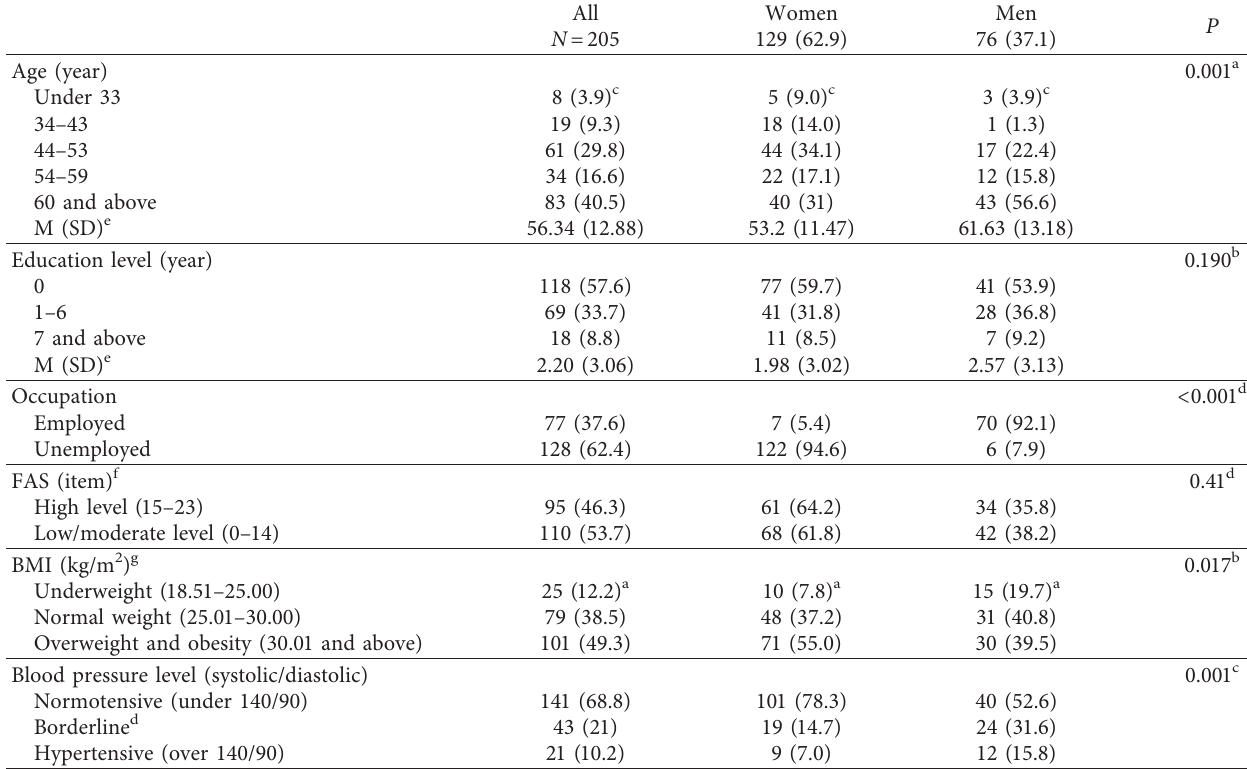
Table 1: Patients’ characteristics.